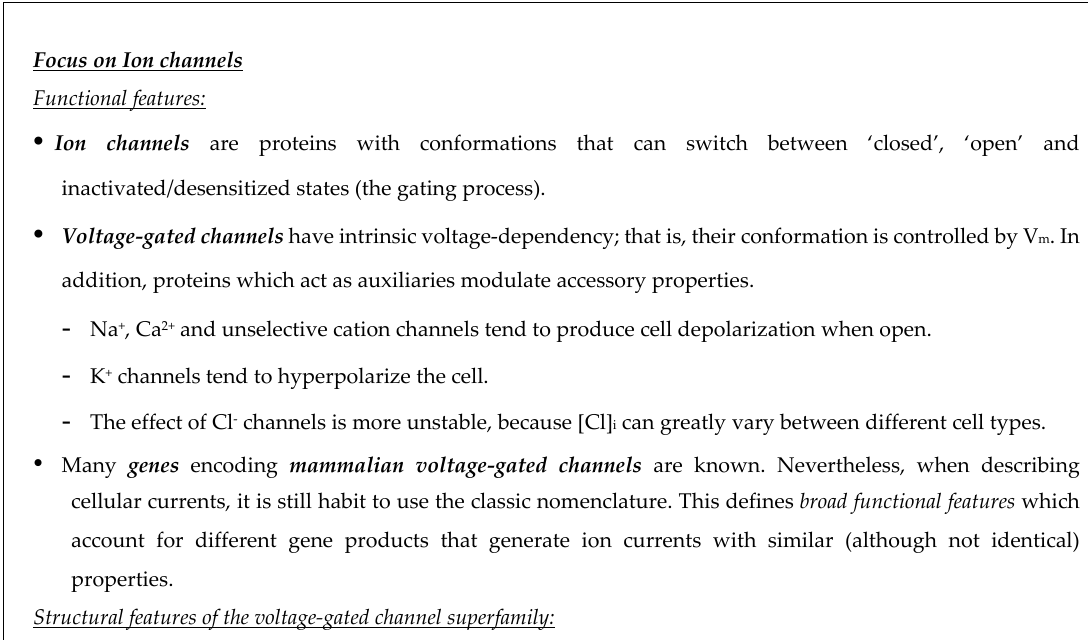
Box 1. Insights into ion channel main structure